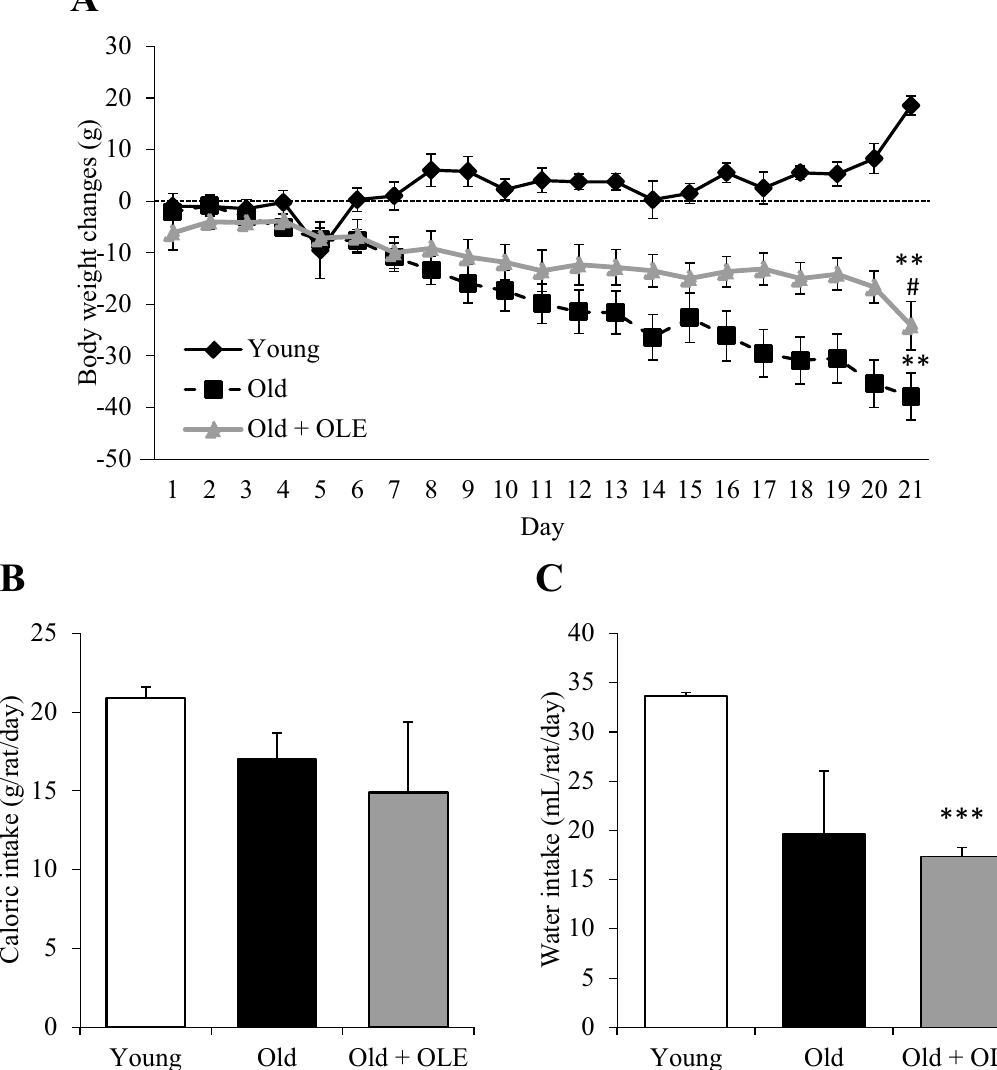
Figure 1. Effects of aging and a 21-day treatment with the OLE on rat body weight gain ( A ), daily food ( B ) and water ( C ) intake. Values are represented as mean ± SEM. ** p < 0.01 vs. Young; # p < 0.05 vs.